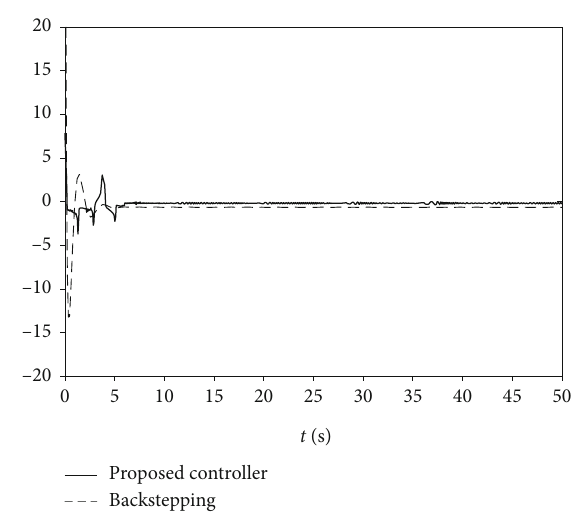
Figure 5: Elevator de fl ection.